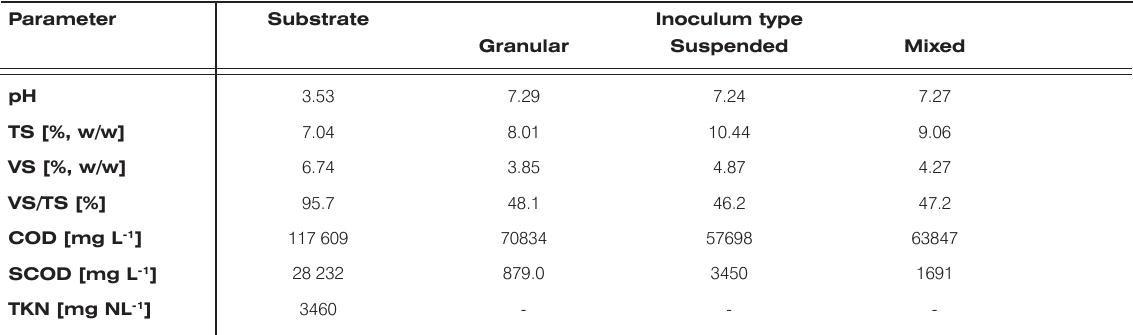
Table 1. Physical-chemical characteristics of the substrate and inocula used in the experiments. The values presented are the mean of at least two measurements.